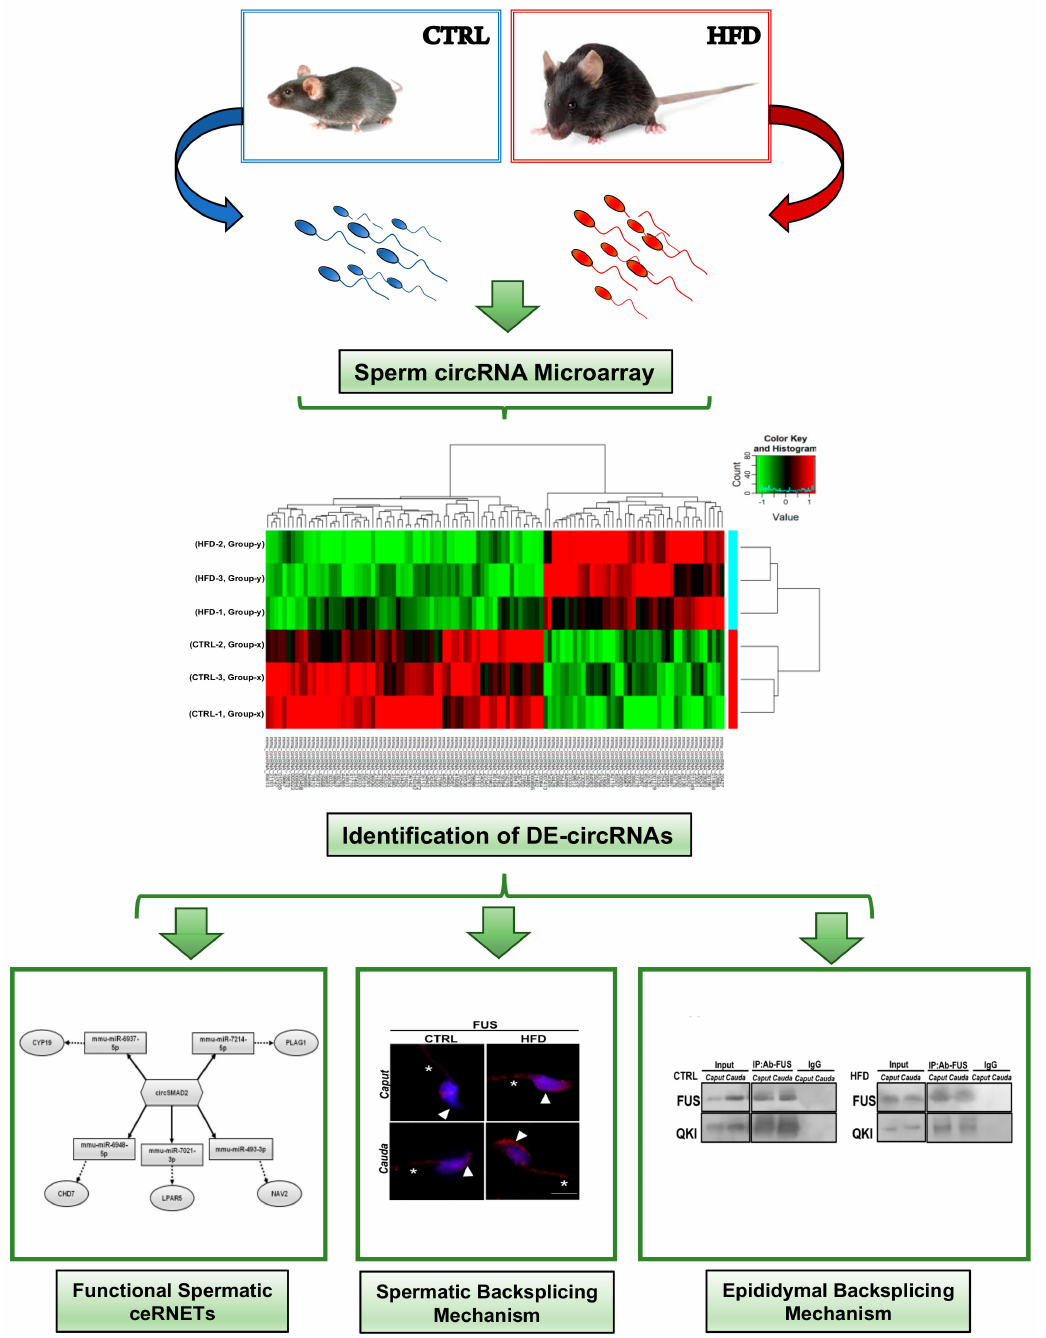
Figure 7. Schematic representation of experimental